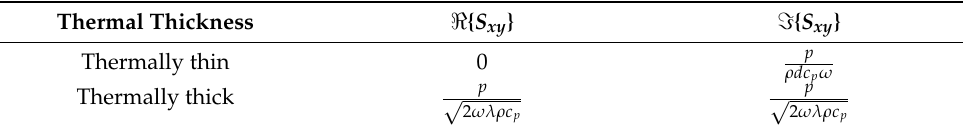
Table 1. Real and imaginary part of the temperature signal from [8]